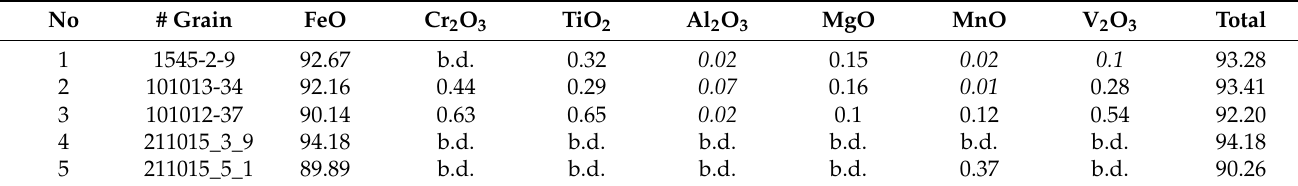
Table 8. Chemical composition of secondary magnetite (in